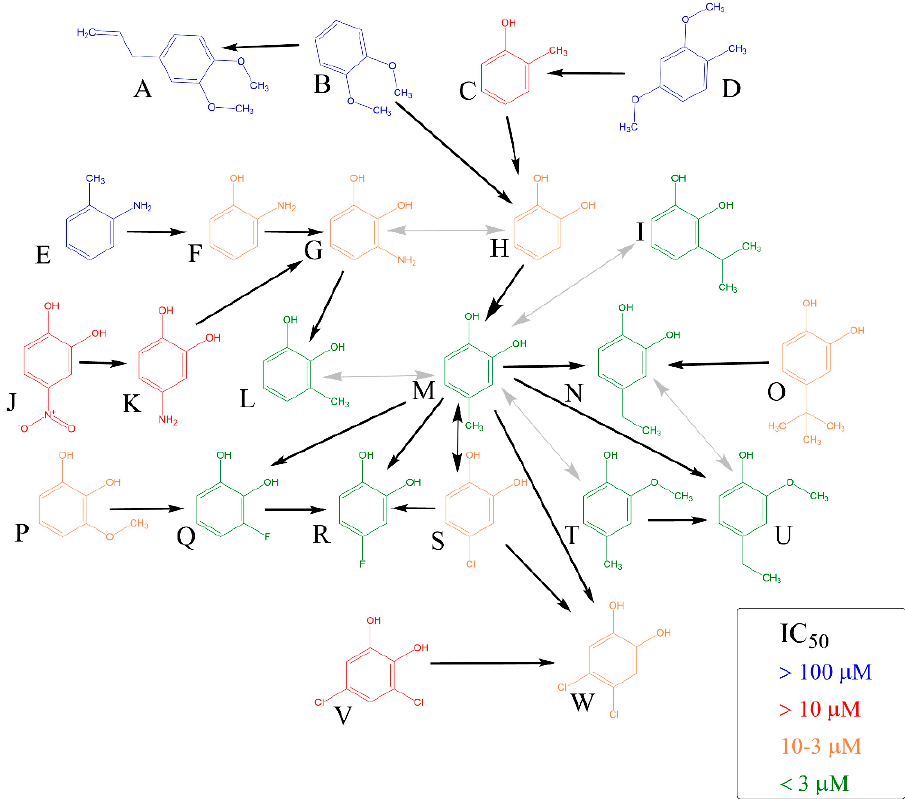
Figure 3. Comparison of Antiplatelet Activity of All Compounds on Arachidonic Acid-platelet Ag- gregation. The direction of black arrow shows a more potent compound. Analysis was performed by comparing 95% confidence intervals of aggregation curves. Two-way grey arrows mean no statistical difference in the activity. ( A ): 4-allyl-1,2-dimethylcatechol, ( B ): 1,2-dimethylcatechol, ( C ): o -cresol, ( D ): 2,4-dimethoxytoluene, ( E ): o -toluidine, ( F ): 2-aminophenol, ( G ): 3-aminocatechol, ( H ):